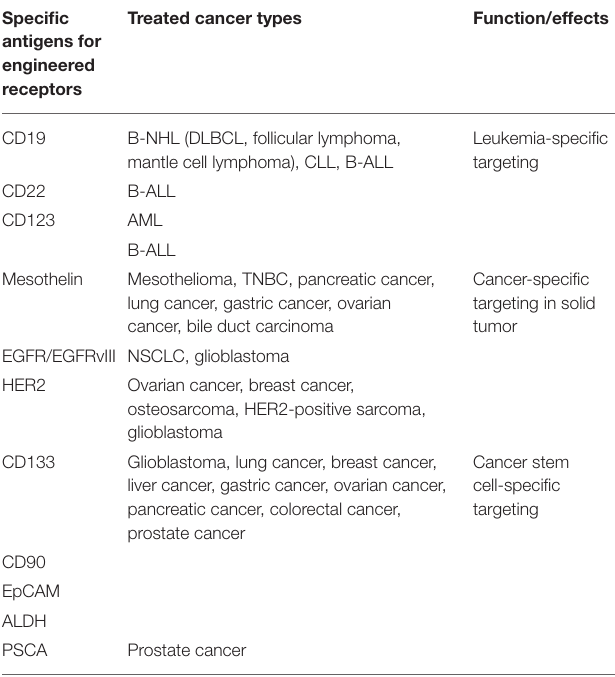
TABLE 1 | Engineering strategies for effector chimeric antigen receptor-T (CAR)-T cell. Specific antigens